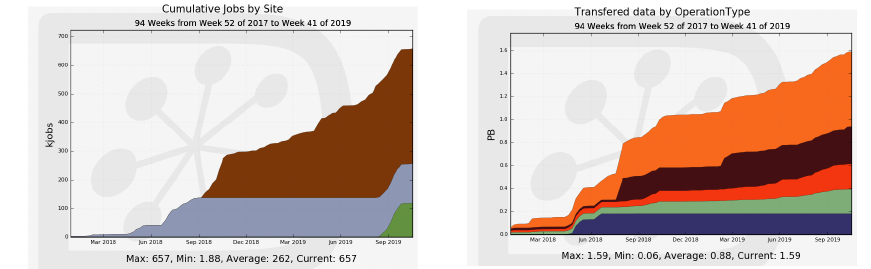
Figure 4. Current Project 8 computing utilizations. The left figure shows the number of cumulative jobs per computing site (top 2 sites are at PNNL). The right figure shows the amount of data transfer per operation type (dominated by transfers between UW and